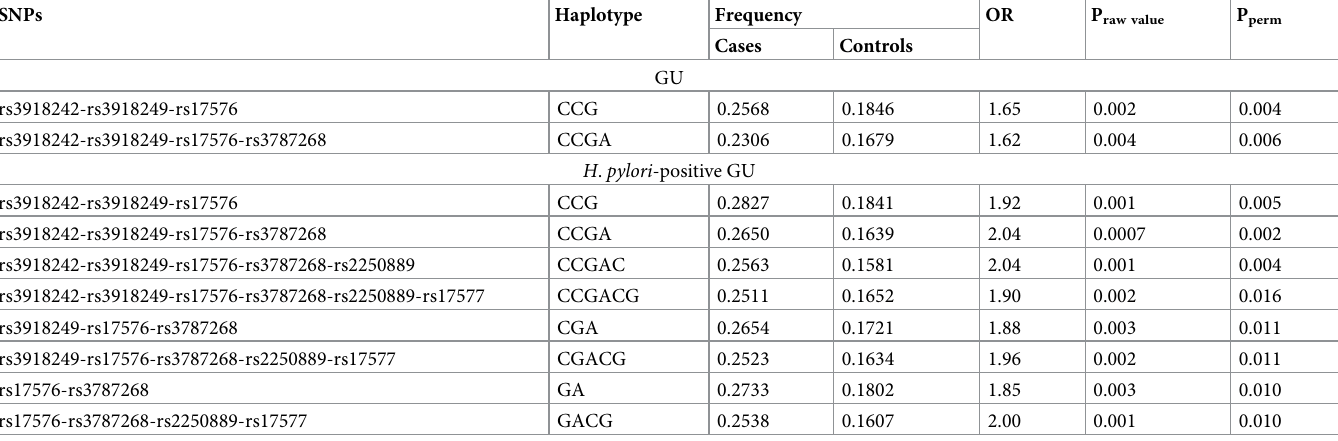
Table 4. Significant associations of the MMP9 gene haplotypes with GU and H . pylori -positive